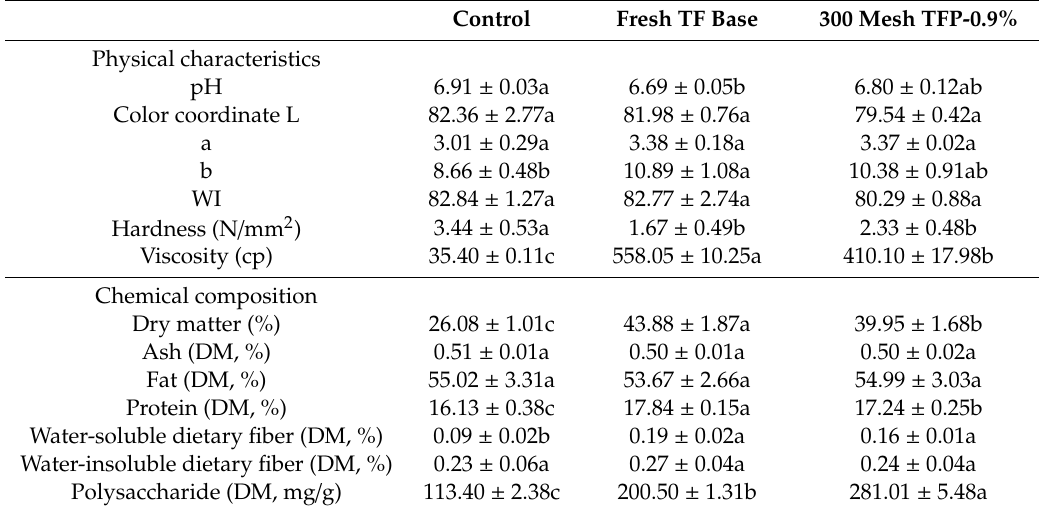
Table 5. Physical characteristics and chemical composition of T. fuciformis ice